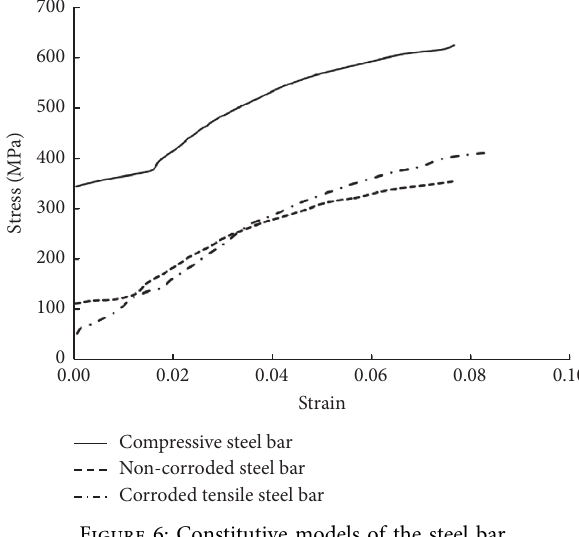
Figure 6: Constitutive models of the steel bar.